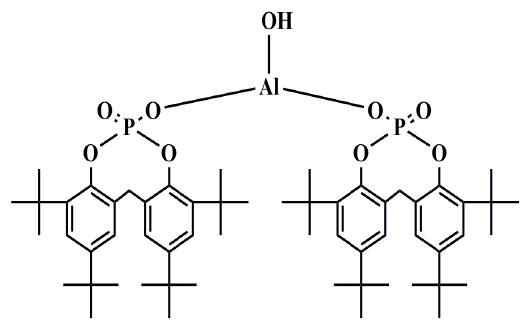
Figure 1. The chemical structure of APAl-OH.